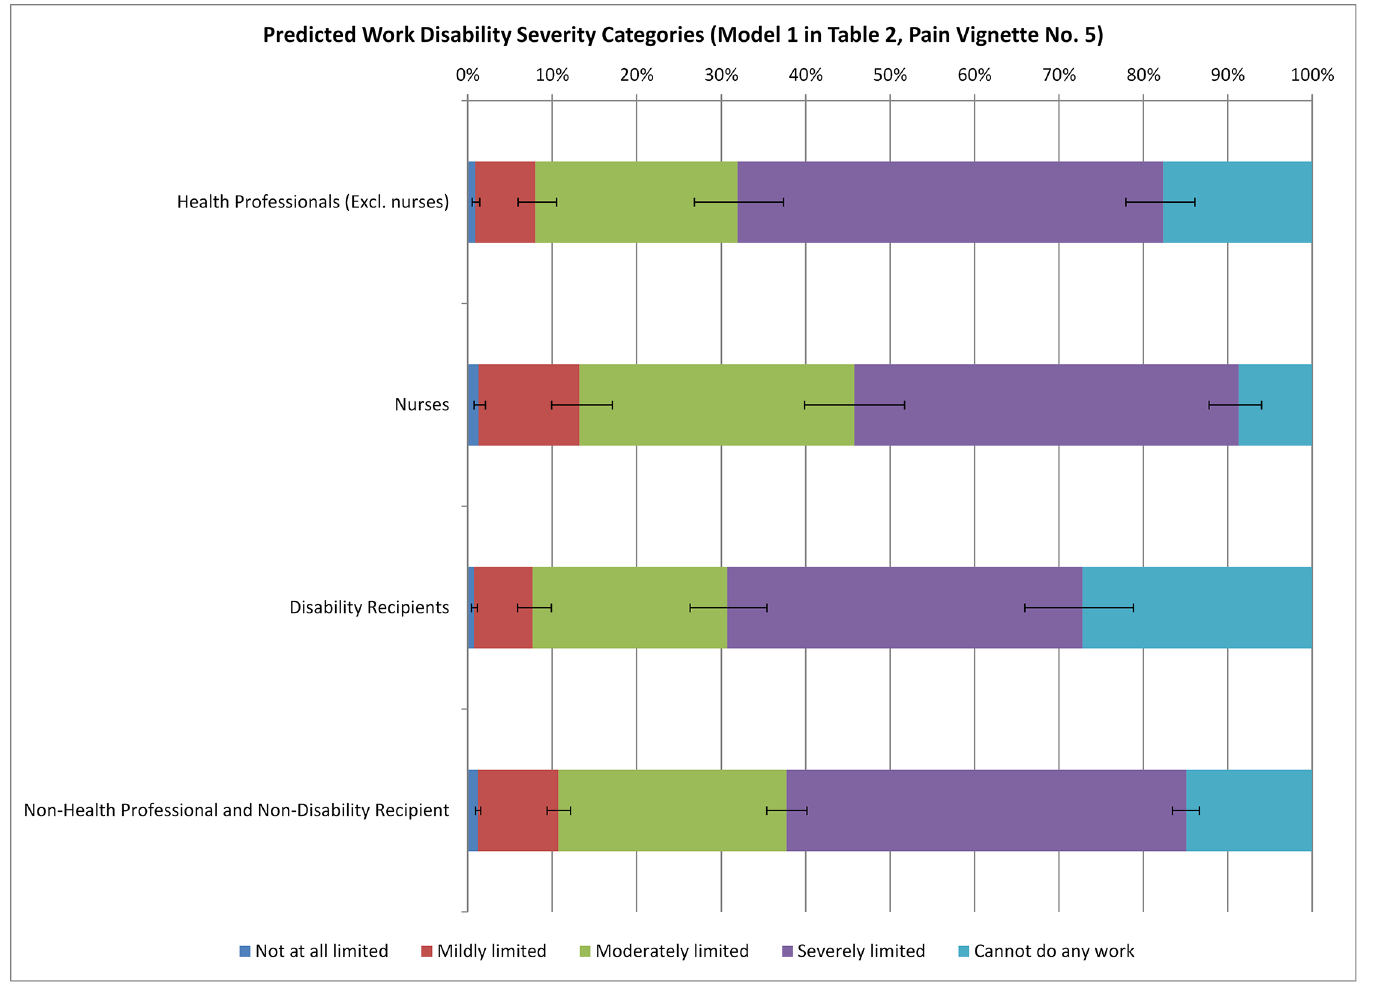
Fig 2. Predicted Distribution of Work Disability Severity Categories (Model 1 in Table 2, Pain Vignette No. 5).